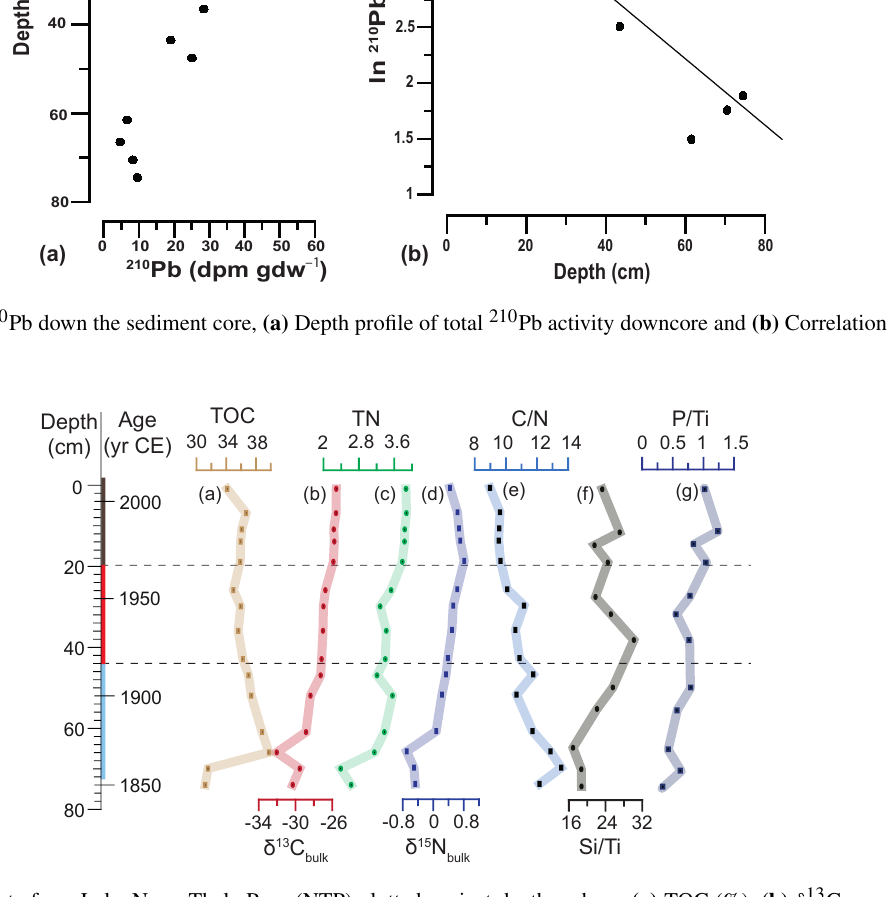
Figure 3. Geochemical data from Lake Nong Thale Pron (NTP) plotted against depth and age (a) TOC (%), (b) δ 13 C bulkorg , (c) TN (%), (d) δ 15 N bulkorg , (e) C / N, (f) Si / Ti and (g) P / Ti. The dashed lines represent the transition between the different units I, II, and